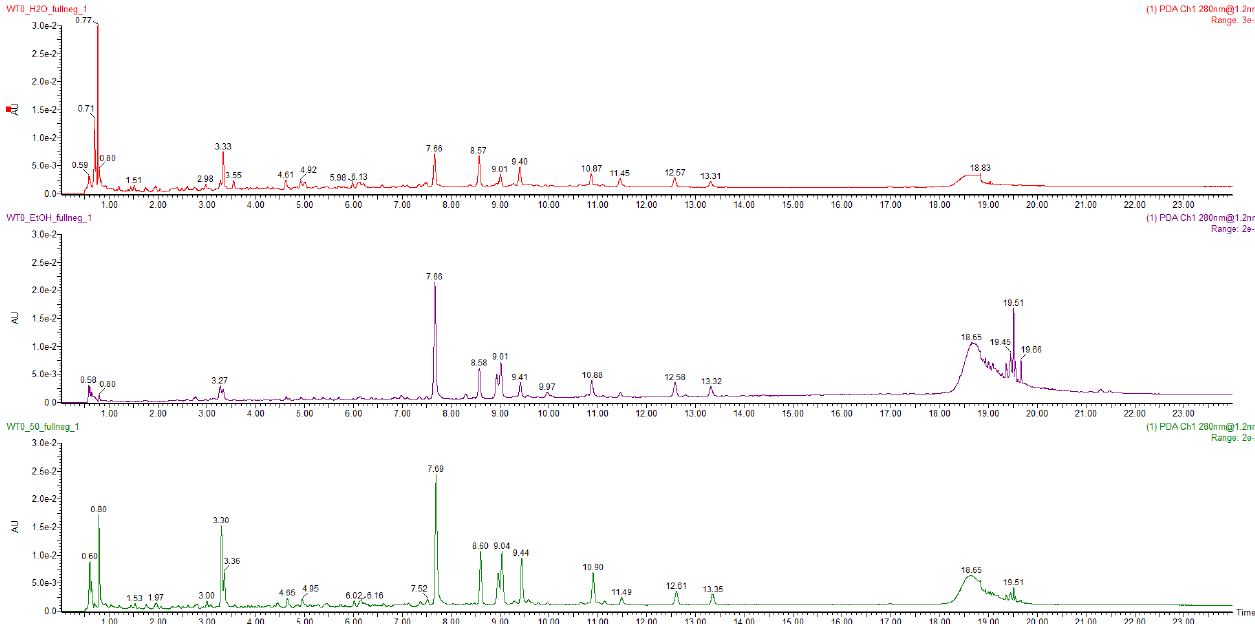
Figure 1. USAE chromatographic profile of H 2 O (red line), EtOH (purple line), and EtOH50% (green line) extracts (0.5 mg mL − 1 ) at a wavelength of 280 nm. Table 2. Metabolites identified in the green extract of C. cardunculus